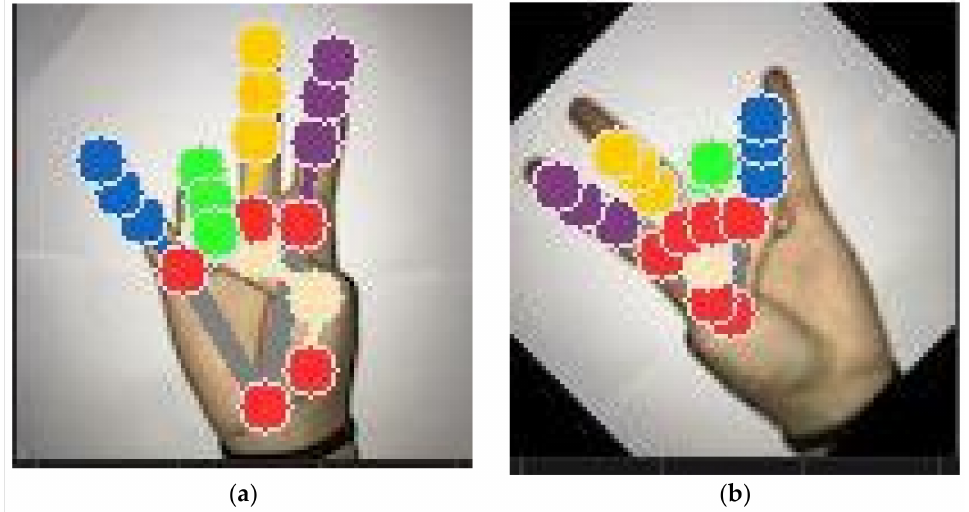
Figure 11. Detection and extraction of hand landmarks using Mediapipe. ( a ) Good result, ( b ) distorted